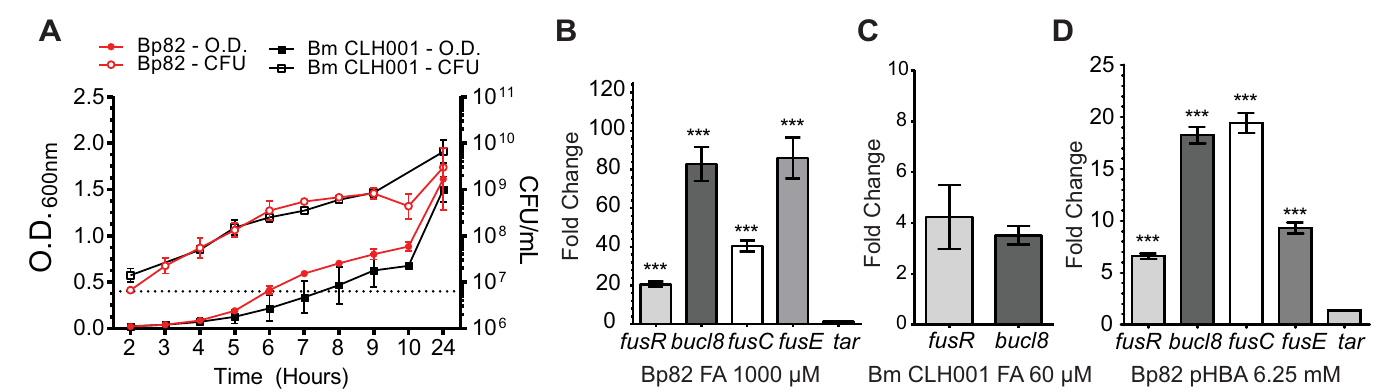
Fig 4. Effect of FA and pHBA on gene transcription within fusR-bucl8-fusCD-fusE operon. (A) Growth curves of B . pseudomallei strain Bp82 and B . mallei strain CLH001. Cultures were grown in strain-specific broth and optical density (O.D.) and colony forming units (CFU) were recorded. Dotted line represents OD of 0.4. Error bars represent ± SEM. (B-D) RT-qPCR was performed on RNA samples isolated from cultures of the indicated strain, untreated and treated with substrate, at an OD 600 of ~0.4 for 1 hour. Graph shows fold change of relative gene expression compared to untreated cultures and normalized to transcription of 16S rRNA gene. Technical and experimental replicates were done in triplicate. One-way ANOVA with Tukey’s multiple comparison test of the log10 –transformed fold change. Significance shown is in comparison to tar ; ��� p < 0.001. Error bars represent ± SEM. (B) Transcription activation of fusR-bucl8-fusCD-fusE genes in Bp82 with 1000 μ M FA. The downstream tar gene is assumed outside of the fusR-bucl8 operon. (C) Transcription activation of fusR and bucl8 in CLH001 with 60 μ M FA. (D) Transcription activation of Bucl8 regulon in Bp82 with 6.25 mM pHBA.